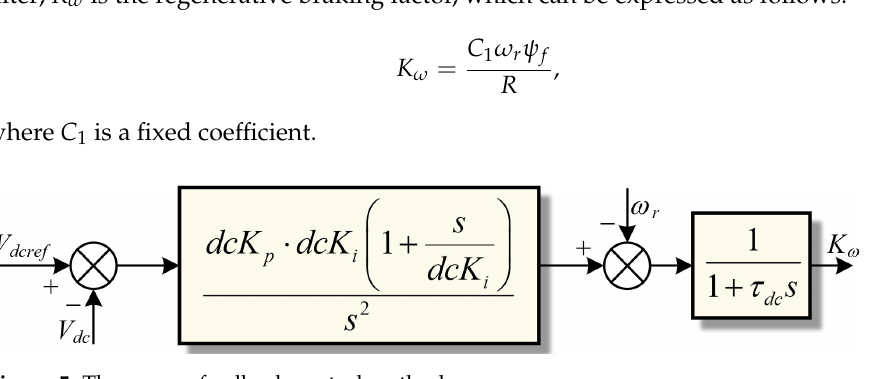
Figure 4. The input power function diagram of PMSM at various ω values ( ψ f = 0.3 Wb, R = 0.8 Ω ).